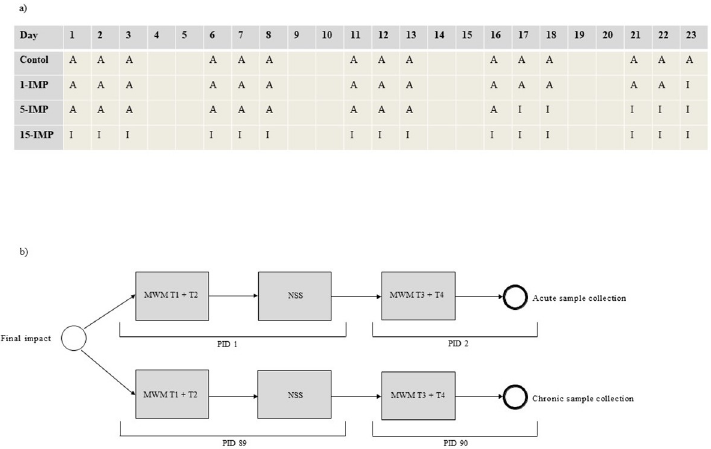
involved MWM trial 1 + 2 and NSS on PID 1 for acute groups and PID 89 for chronic groups, followed by MWM trial 3 + 4 and sample collection on PID 2 for acute groups and PID 90 for chronic